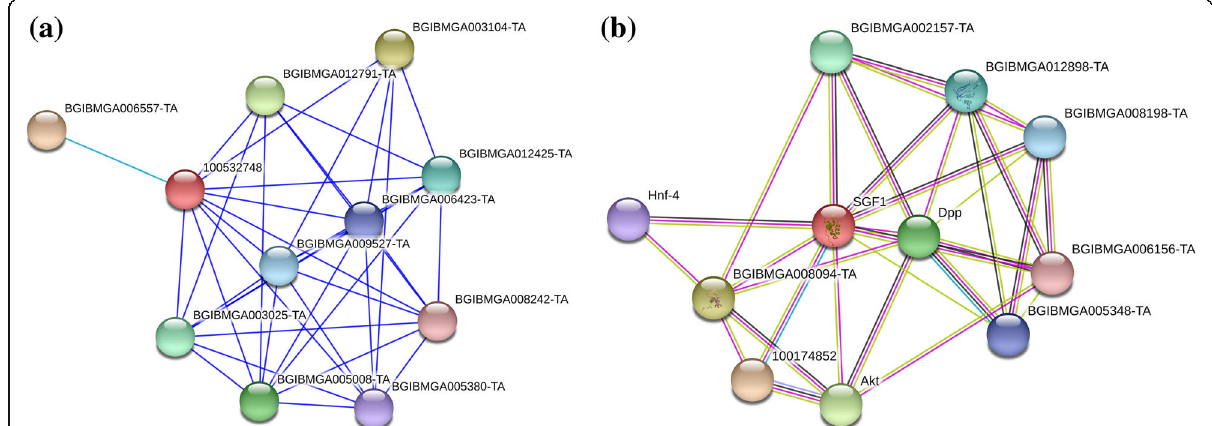
Fig. 13 STRING analysis for cocoonase (BAJ46146.1, a ) and sericin (NP_001037329.1, SGF1-Silk gland factor 1; regulates the transcription of the sericin-1 gene via interaction with the SA site, b ) proteins. Line color indicates the type of interactions; line thickness indicates the strength of data support; line shape indicates the predicted mode of action; network nodes represent proteins. Each node represents all proteins produced by a single protein encoding gene locus. Colored nodes represent query proteins of first shell of interactors. White nodes represent second shell of interactors. Empty nodes represent proteins of unknown 3D structure. Filled nodes represent some 3D structure is known or predicted. Edges represent protein – protein associations.